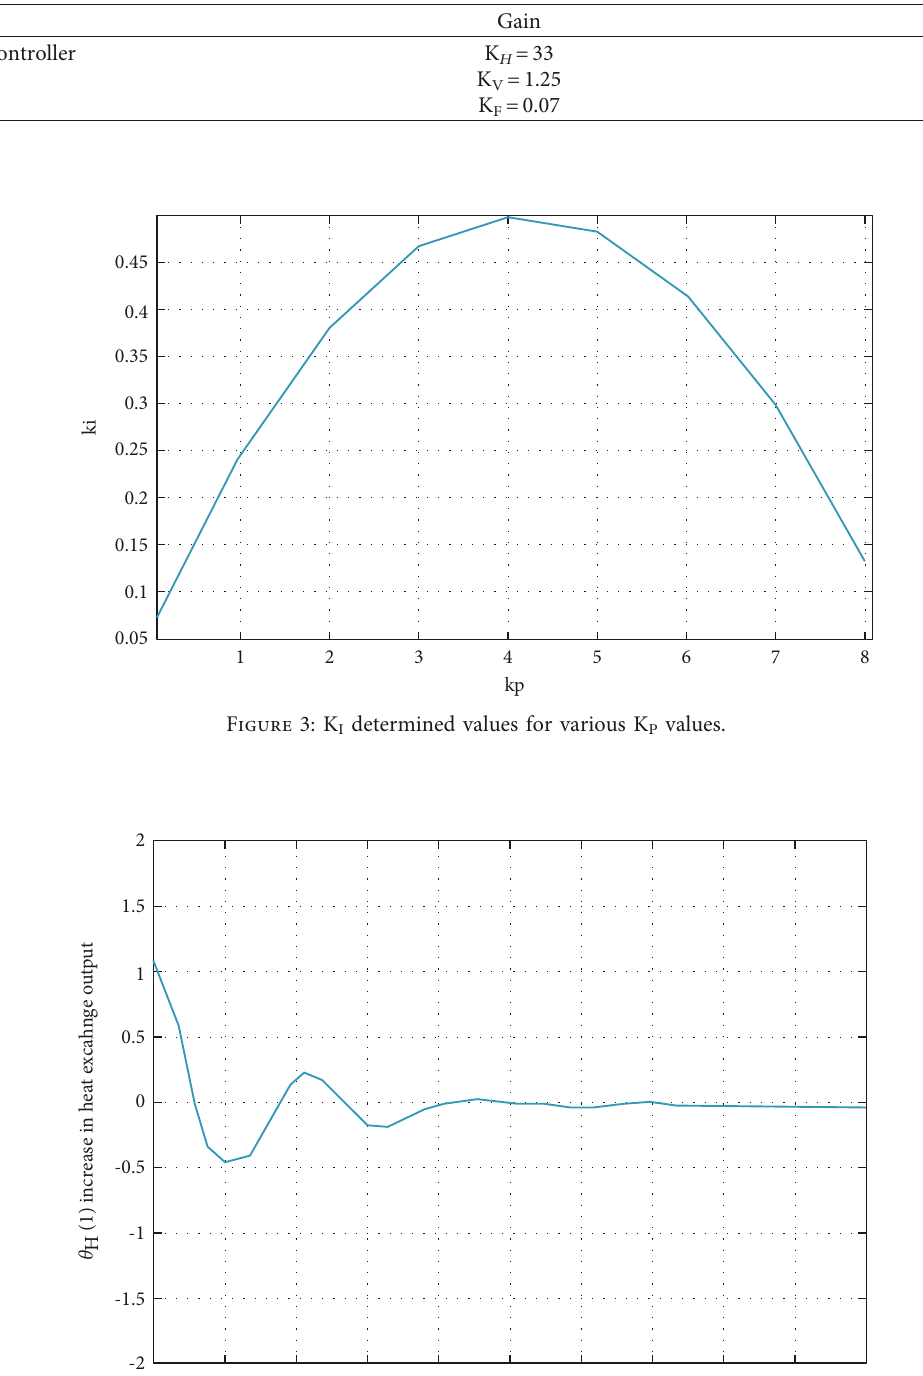
Table 1: Temperature control system Parameter